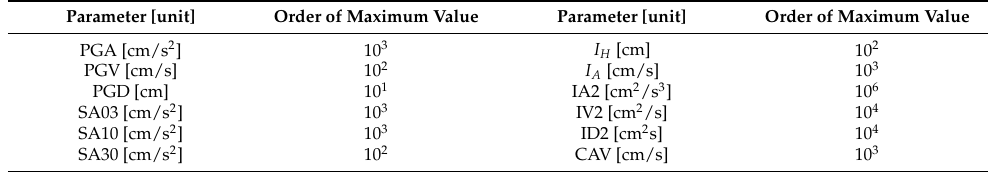
Table 2. Ranges of significant RAN recorded